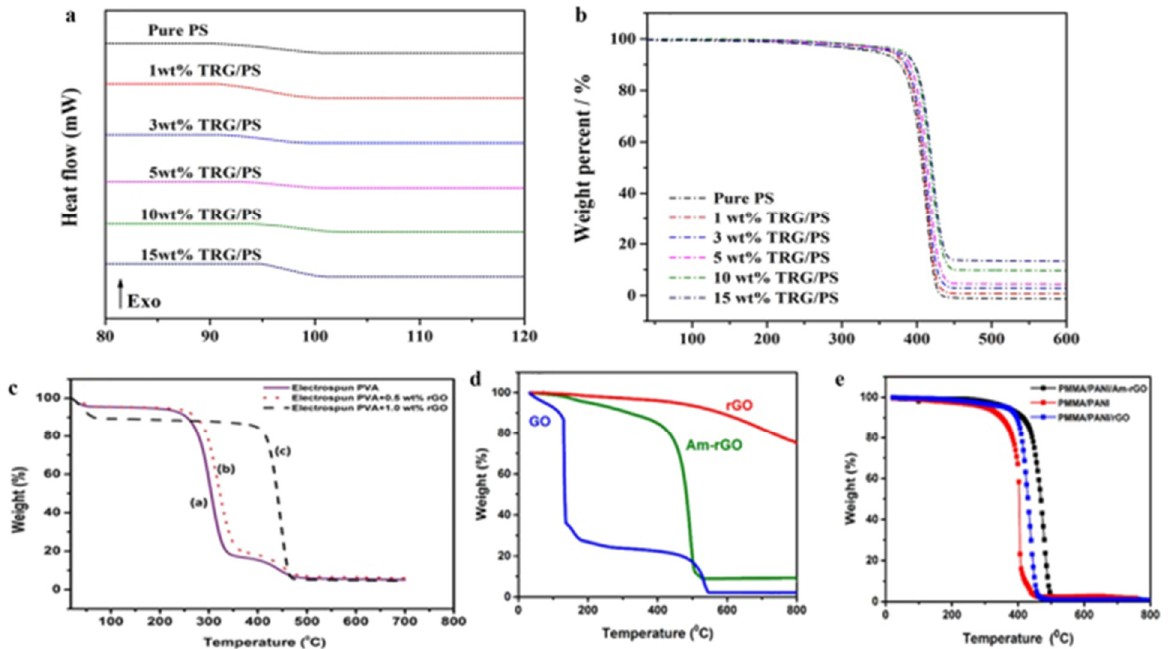
Figure 5. Dimensionally stable anodes (DSC) ( a ) and thermogravimetric analysis (TGA) ( b ) curves of pure PS matrix and the TRG/PS nanocomposites. Reproduced with permission from [154]. Copyright 2018 Elsevier. ( c ) TGA curves of electrospun PVA mats mixed with GO. Reproduced with permission from [155]. Copyright 2019 American Scientific Publishers. ( d ) TGA curves of rGO, rGO, and AM-rGO. ( e ) TGA curves of electrospun PMMA/PANI/AM-rGO, PMMA/PANI/rGO, and PMMA/PANI NFs. As shown in ( e ), the thermal degradation temperature of PMMA/PANI/Am-rGO NFs increased to~441 °C, a magnitude higher than that of the PMMA/PANI samples at~348 °C. Both ( d , e ) are reproduced with permission from [156]. Copyright 2017 MDPI.